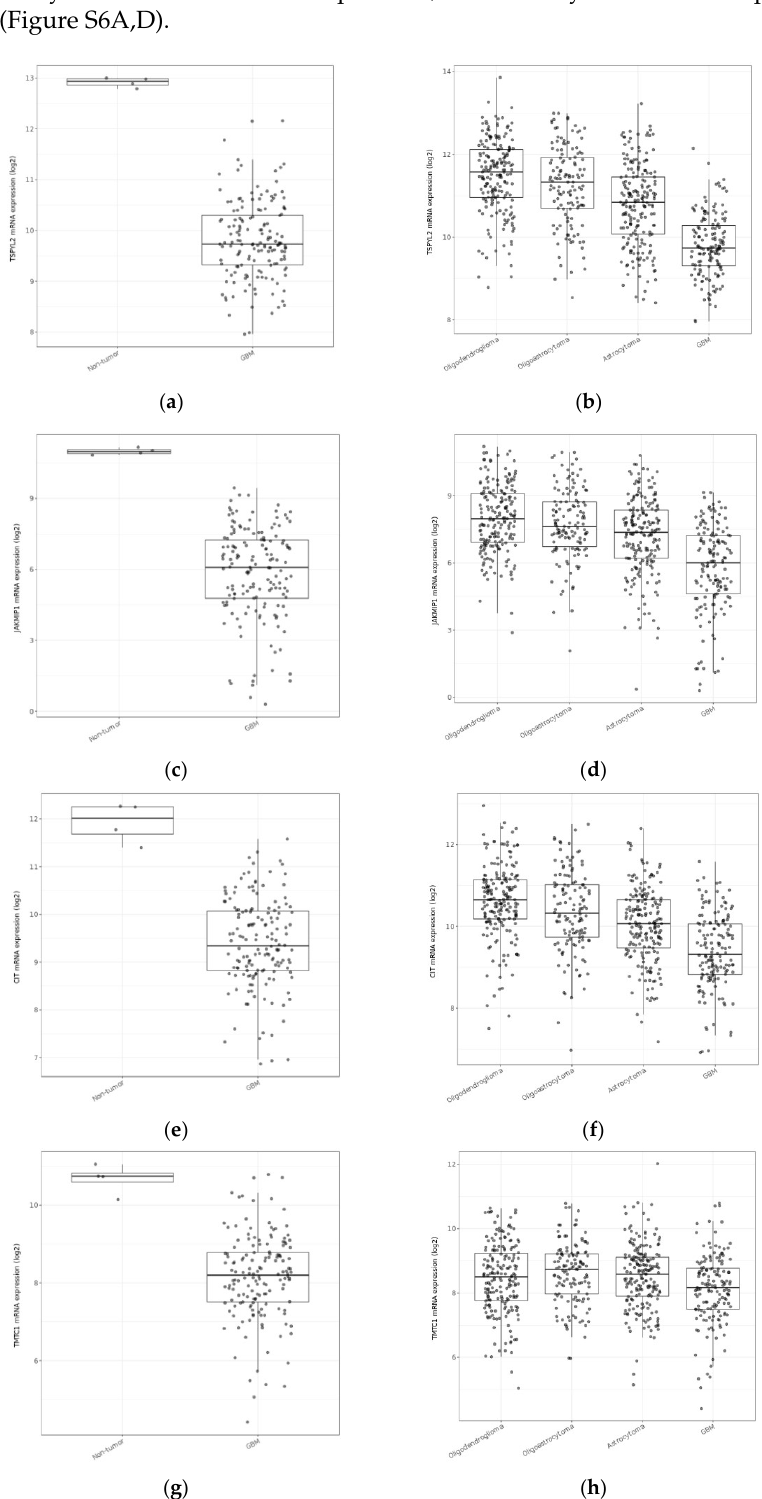
Figure 1. All pairwise comparisons of mRNA expression between GBM and non-tumor samples and also the other glioma subtypes were significantly different ( p < 0.001; t -tests) for each of the potential prognostic genes: testis-specific protein Y-encoded 2; ( a , b ) (TSPYL2), Janus kinase and microtubule-interacting protein 1; ( c , d ) (JAKMIP1), citron rho-interacting serine/threonine kinase; ( e , f ) (CIT), and transmembrane O-mannosyltransferase targeting cadherins 1; ( g , h ) (TMTC1).